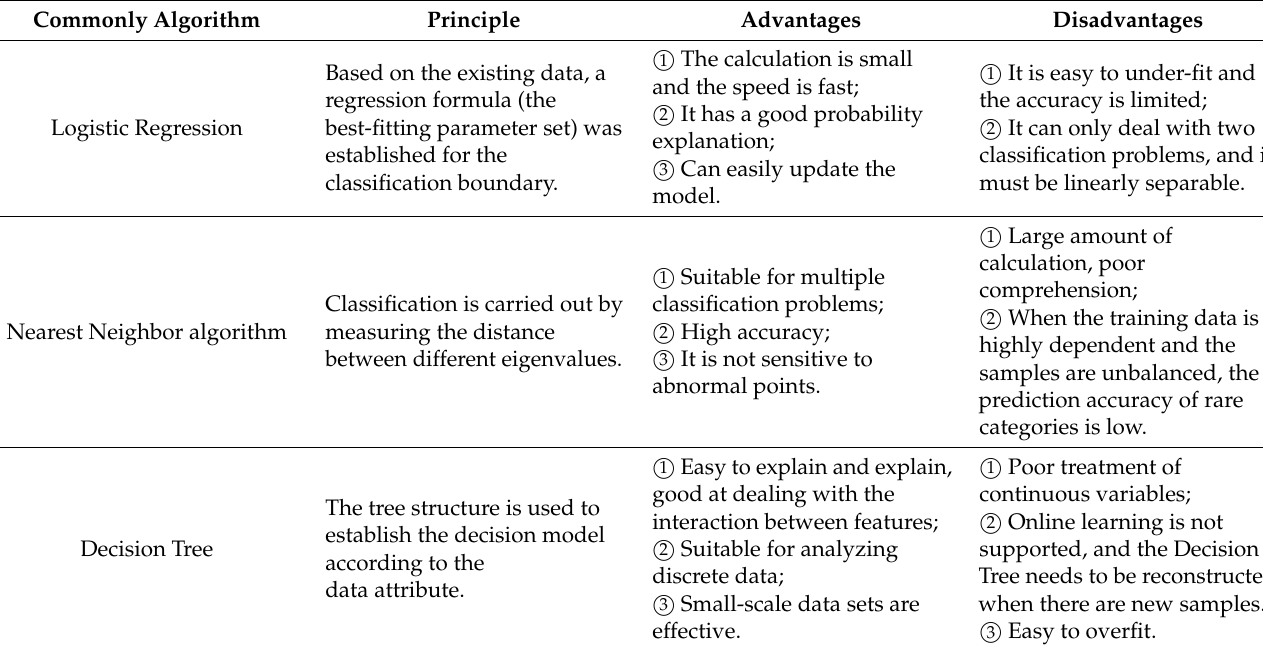
Table 2. Comparison and analysis of commonly used machine learning classification